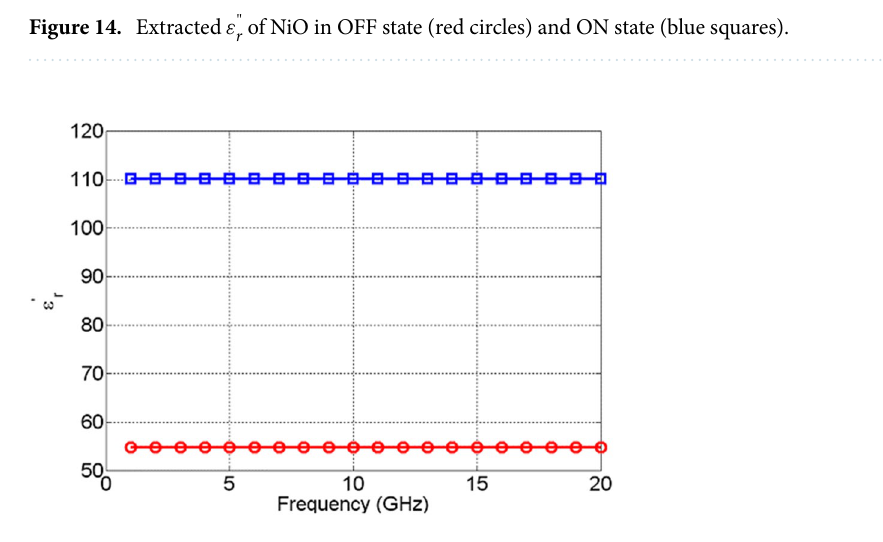
Fig. 16. The loss tangents in the non-actuated and actuated states for both NiO and TiO 2 are shown in Figs. 17 and 18, respectively, which provide a more intuitive view on the dielectric behaviour of NiO and TiO 2 . Here, it